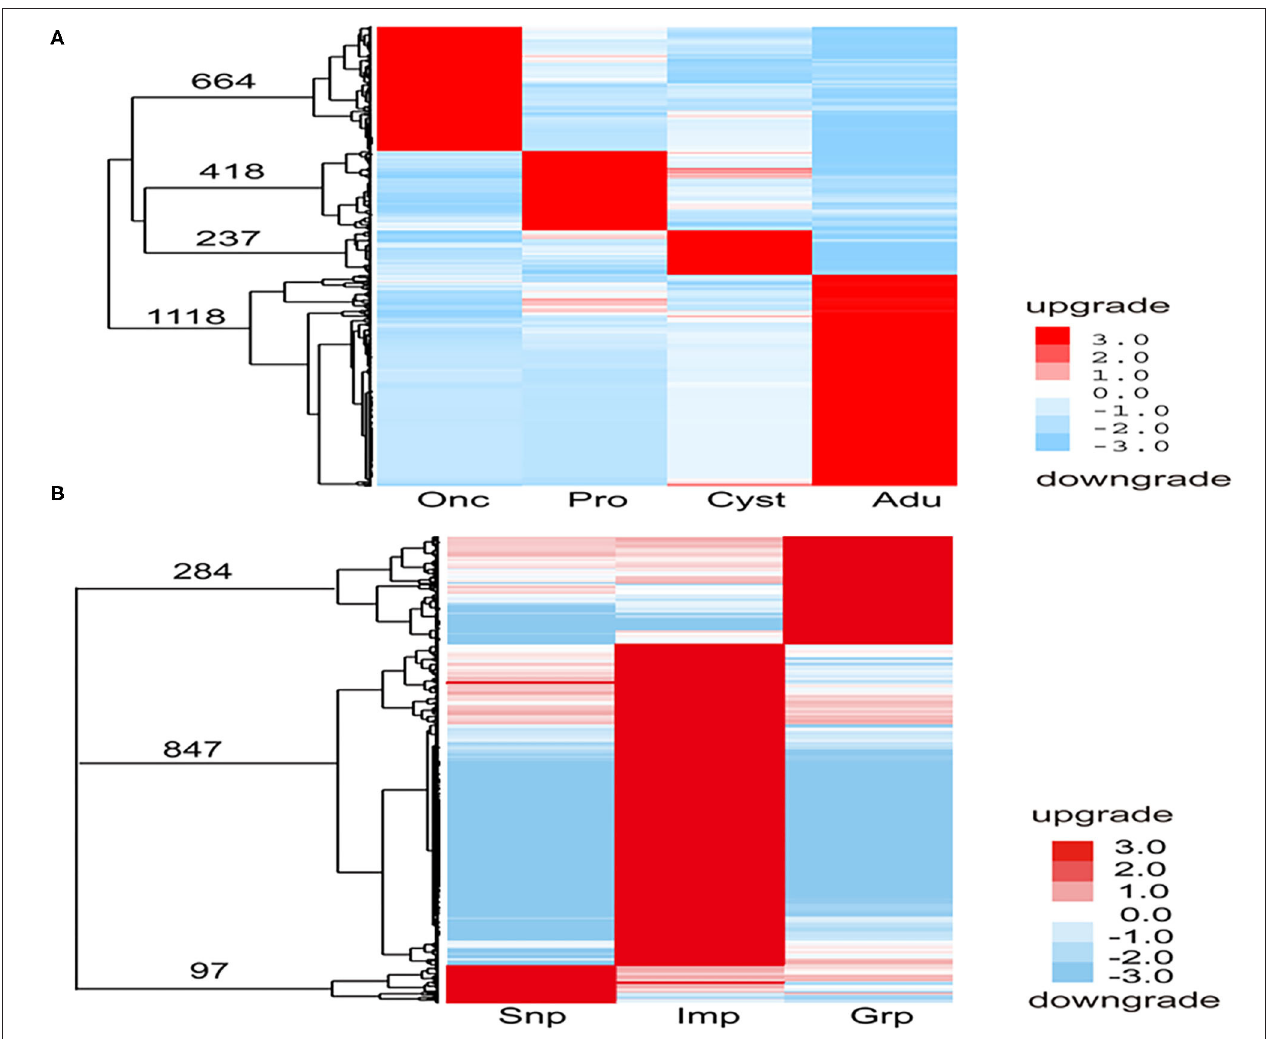
FIGURE 2 | Specific upregulated genes in each development stage and tissue of T. multiceps. (A) Specific upregulated genes in each developmental stage of T. multiceps . (B) Specific upregulated genes in Snp, Imp, and Grp of adult T. multiceps